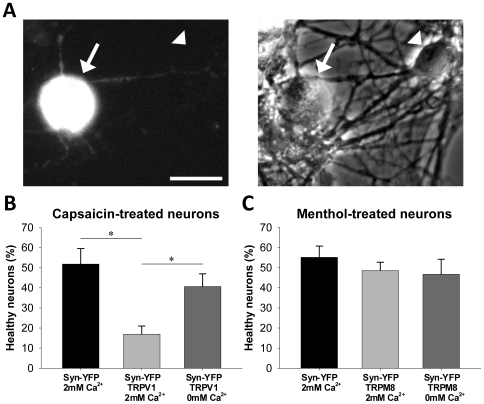
Agonist-induced toxicity in transfected neurons.(A) An example TRPV1-transfected neuron designated “unhealthy” (arrow) in the same field as a “healthy” non-transfected neuron (arrowhead). Syn-YFP fluorescence (left panel) and phase contrast (right panel) images are shown. Note the swollen cell body of the unhealthy cell. Scale bar represents 30 µm. (B) Transfected neurons treated 4 hr with 500 nM capsaicin, 25 µM D-APV, and 1 µM NBQX in culture media with (2 mM) or without (0 mM plus 500 µM EGTA) calcium were assessed as “healthy” or “unhealthy” by a naïve observer. Significantly fewer TRPV1-transfected neurons treated in calcium were healthy than either YFP-transfected neurons treated in calcium or TRPV1-transfected neurons treated without calcium (ANOVA, p<0.01; post hoc Tukey test, p<0.05). (C) Transfected neurons treated 4 hr with 100 µM menthol, 25 µM D-APV, and 1 µM NBQX in culture media with or without calcium were assessed as “healthy” or “unhealthy” as in (B). There was no significant change in health of TRPM8-transfected neurons compared to YFP-transfected neurons regardless of whether or not they were exposed to extracellular calcium. Error bars represent SEM.